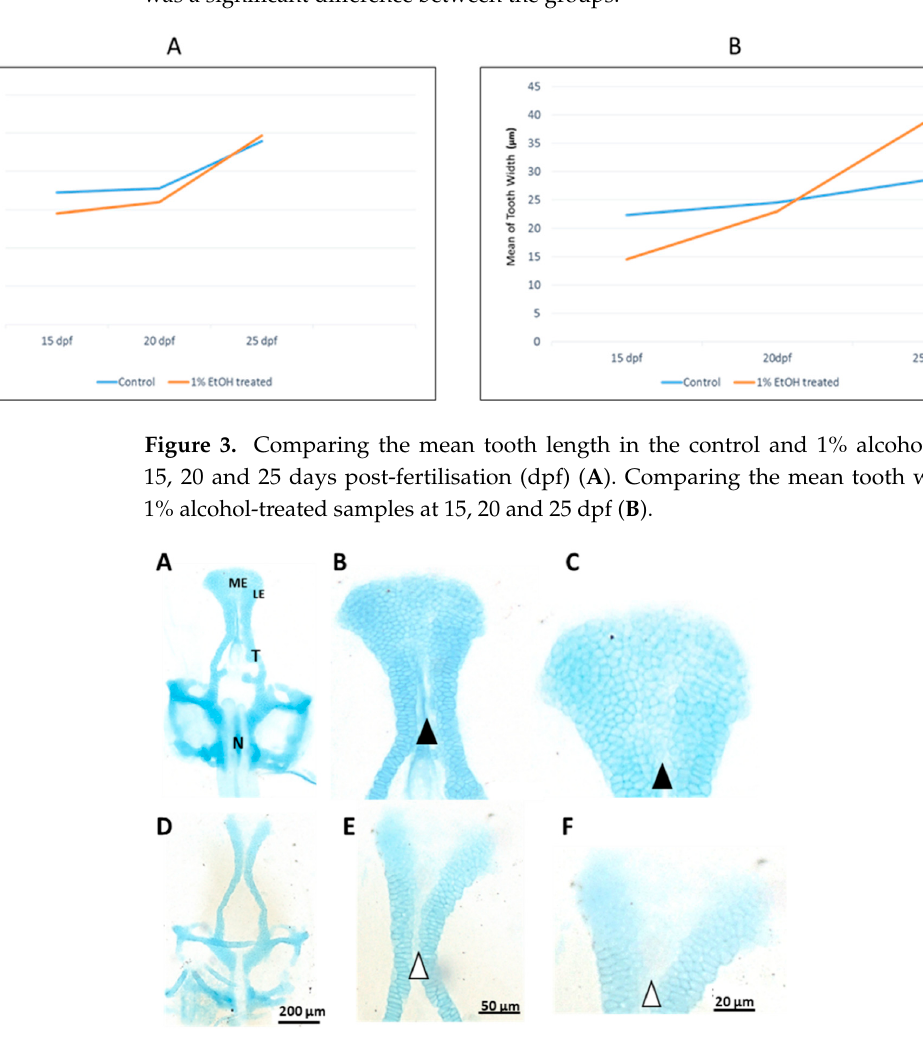
Figure 4. Alcian blue-stained (5 days post-fertilisation) ( A – C ) control and ( D – F ) 1% alcohol-treated zebrafish neurocranium (12 h treatment from 10 to 22 h post-fertilisation). Notice the lower cell density in the medial ethmoid region of ( E , F ) (white arrowheads) compared with ( B , C ) (black arrowheads). LE: lateral ethmoid cartilage; ME: medial ethmoid cartilage; N: notochord; T: